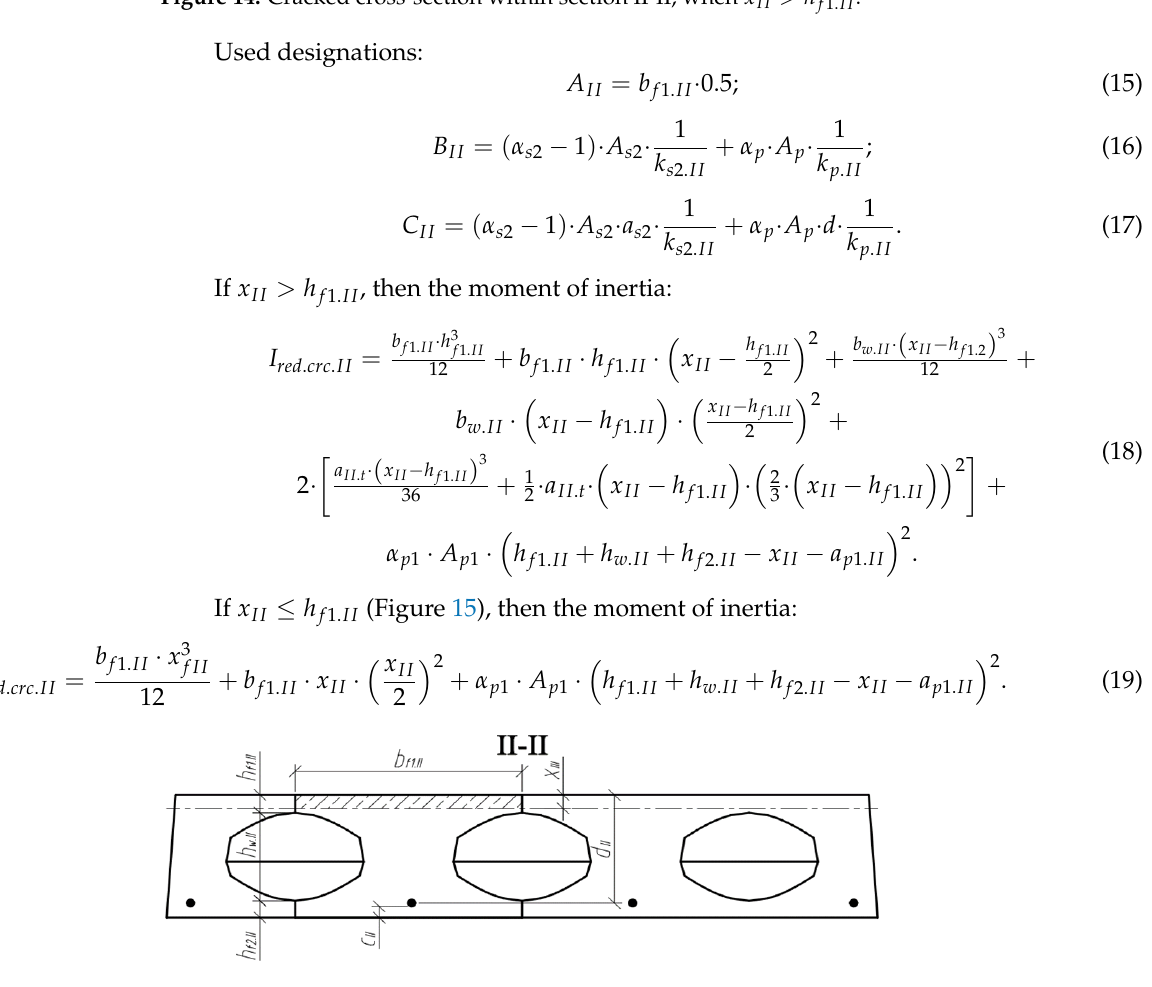
Figure 15. Cracked cross-section II-II, when 𝑥 (cid:3010)(cid:3010) ≤ ℎ (cid:3033)(cid:2869).(cid:3010)(cid:3010) .